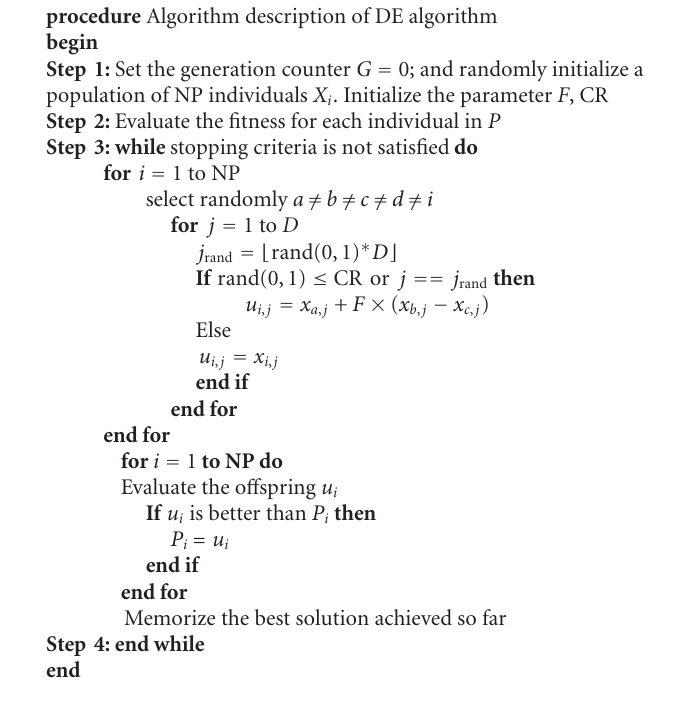
procedure Algorithm description of DE